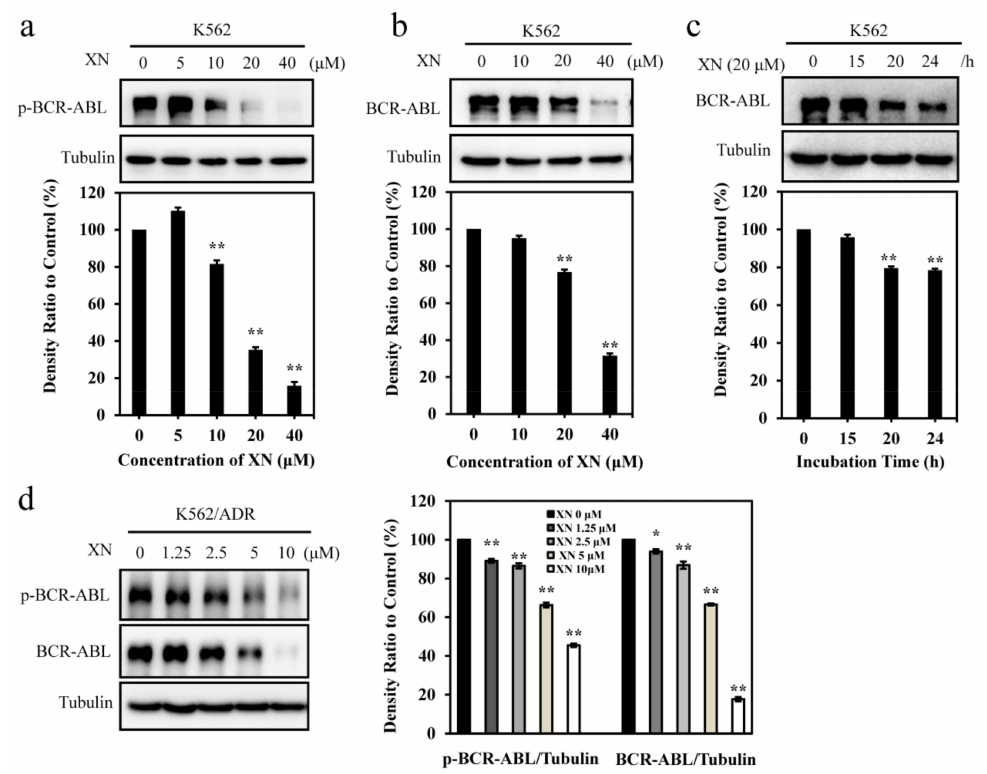
Figure 2. XN decreases the phosphorylated and the total protein level of BCR-ABL. ( a ) XN inhibits the phosphorylation of BCR-ABL. K562 cells were treated with XN (5, 10, 20, and 40 µ M) for 24 h, and cell lysates were then immunoblotted to assess the changes of p-BCR-ABL and BCR-ABL. ( b ) XN concentration dependently decreases the protein level of BCR-ABL. K562 cells were treated with XN (0–40 µ M) for 24 h. The BCR-ABL protein level was blotted by anti-ABL antibody. ( c ) XN time dependently decreases the protein level of BCR-ABL. K562 cells treated with 20 µ M of XN at di ff erent time periods (15, 20, and 24 h). BCR-ABL expression was detected by Western blotting. ( d ) XN inhibits the phosphorylated and the total protein level of BCR-ABL in K562 / ADR cells. K562 / ADR cells were treated with XN (1.25–10 µ M) for 24 h. The p-BCR-ABL and BCR-ABL were determined by Western blotting. Histograms show the relative abundance of p-BCR-ABL or BCR-ABL to the control group. Data are presented as mean ± SD for three independent experiments. * p < 0.05, ** p < 0.01, versus